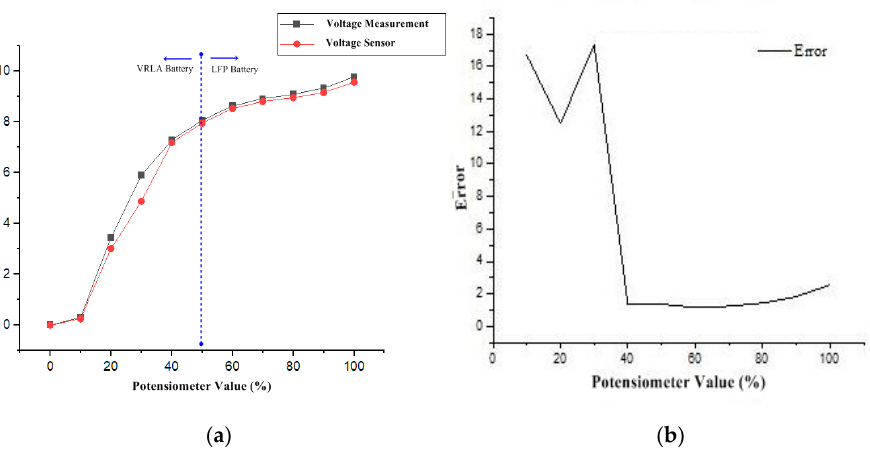
Figure 14. Graph of voltage sensor: ( a ) Voltage value reading; ( b ) Error value.